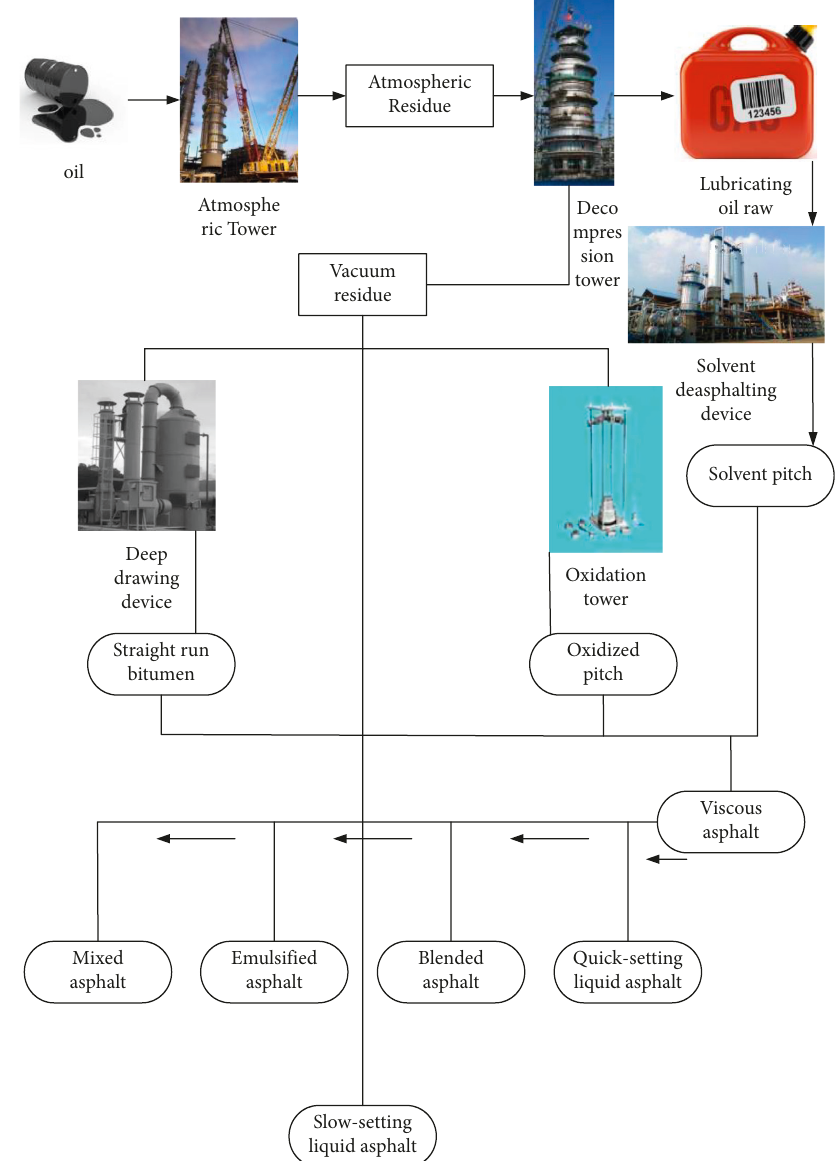
Figure 4: Process flow chart of petroleum asphalt